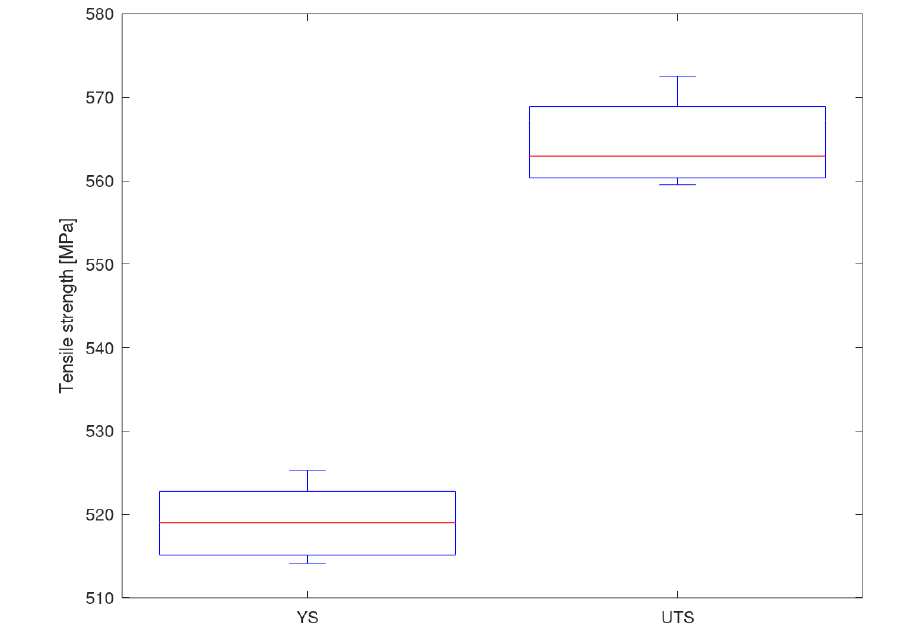
Figure 12. Yield strength and ultimate tensile strength prediction for Al 7010-T6 using the